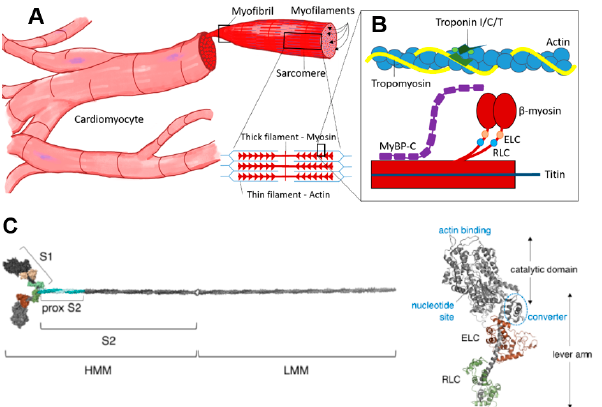
Figure 1. Cardiac contractile machinery from cells to proteins. ( A ) Cardiomyocytes, myofibrils and schematic of sarcomeric structure with thick and thin filaments. ( B ) Schematic showing key sarco- mere proteins and their relative organization. ( C ) Molecular model of isolated myosin II molecule modified from Reference [15] under a CC-BY license (http://creativecommons.org/licenses/BY/4.0/) accessed on 18 January 2022. Different well-defined myosin fragments that are used in various stud- ies are indicated: S1, subfragment 1; S2, subfragment 2; HMM, heavy meromyosin and LMM, light meromyosin. The myosin motor domain, S1, is shown in greater detail to the right, with the essential (ELC) and regulatory light chain (RLC) indicated in brown and green, respectively.